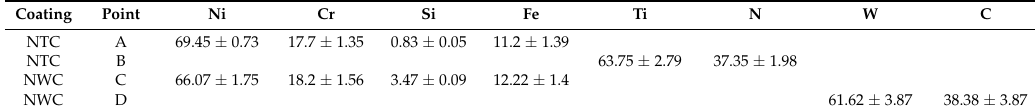
Figure 3. Cross-sectional morphologies of composite coating: ( a,b ) NTC coating; ( c,d ) NWC coating. Table 2. EDS analysis results of different marked areas in Figure 3